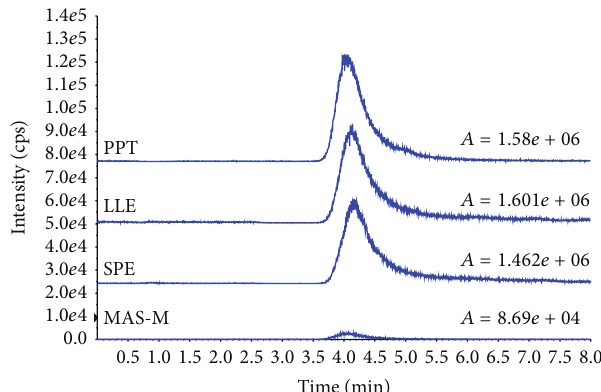
Figure 3: Chromatograms and peak areas of phospholipids in plasma treated with various clean-up methods, where “ 𝐴 ” = peak area of